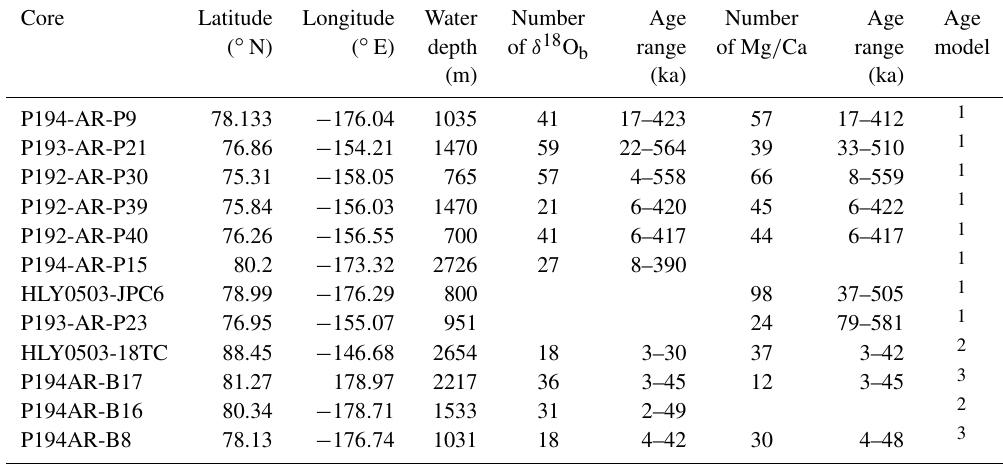
Table 1. Core locations, data availability, and age model sources for the combined Arctic δ 18 O sw reconstruction. Core Latitude Longitude